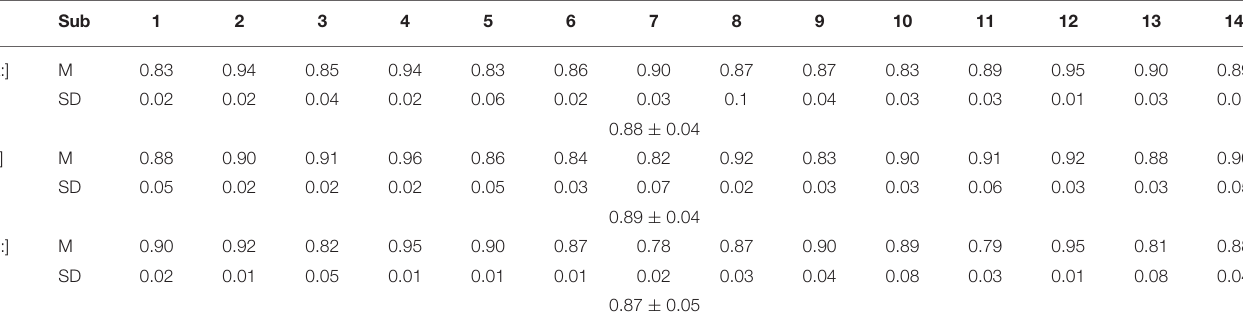
TABLE 1 | The average correlation coefficients between the nRMS of sEMG recordings from all channels and the nMF of the speech signals across all recruited subjects ( p < 0.05).